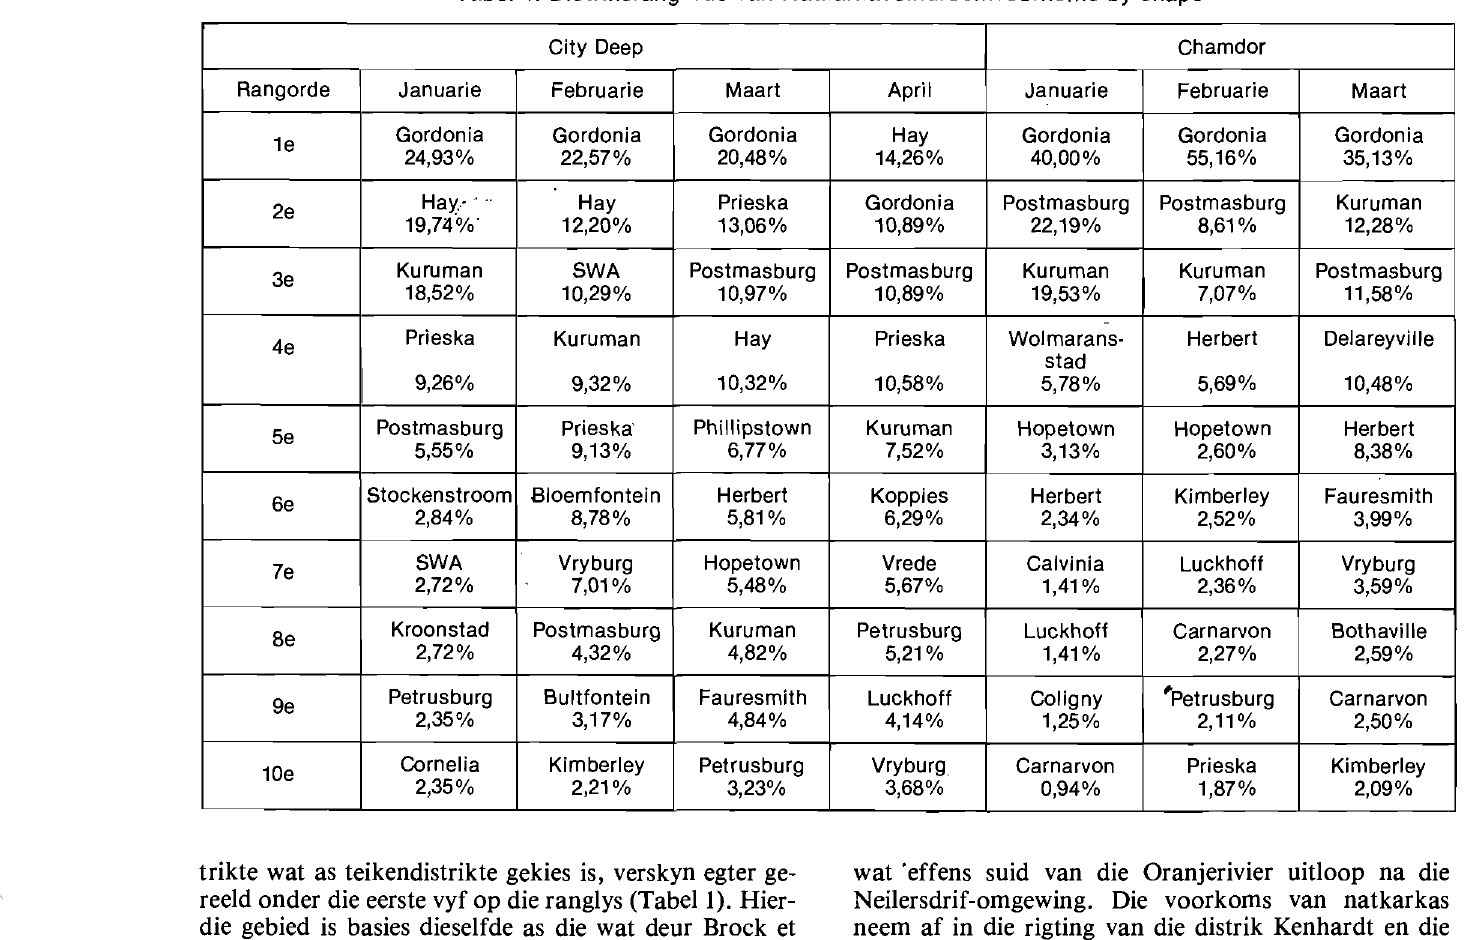
Tabel 1: Distriksrangorde van Natkarkassindroomvoorkoms by skape City Deep